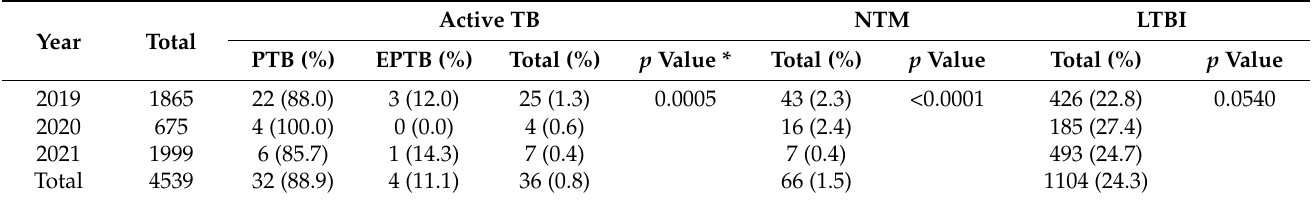
Table 1. TB diagnosis of HIV/AIDS outpatients in Guangxi Province,